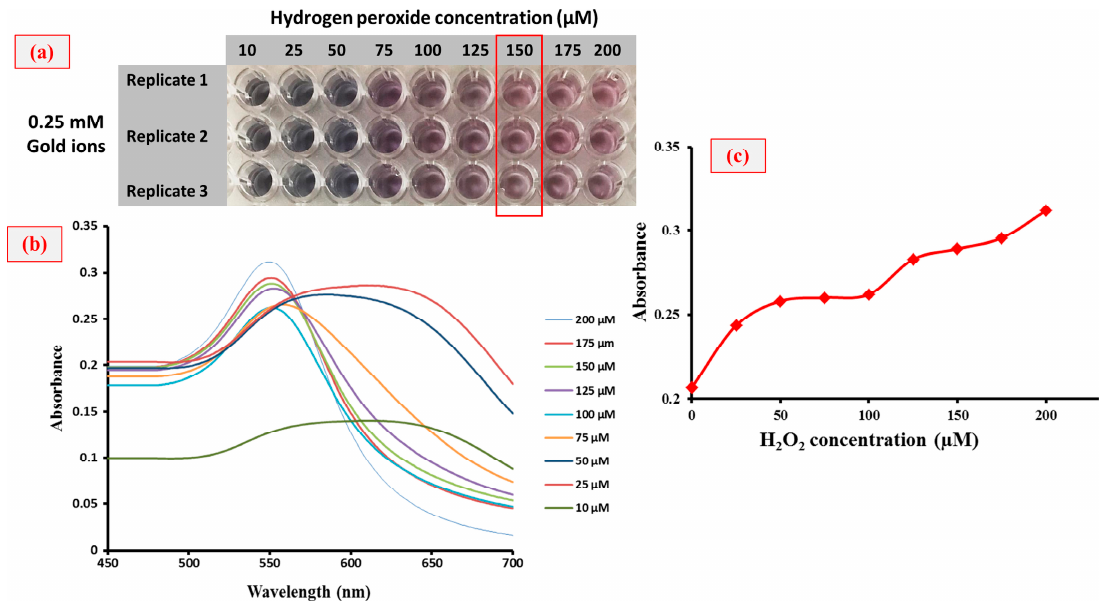
Figure 3. ( a ) Reduction of gold ion to GNPs, ( b ) absorption spectra for the peak at 550 nm, and ( c ) the absorbance curve towards the formation of GNPs at different concentrations (10–200 µM) of hydrogen peroxide.